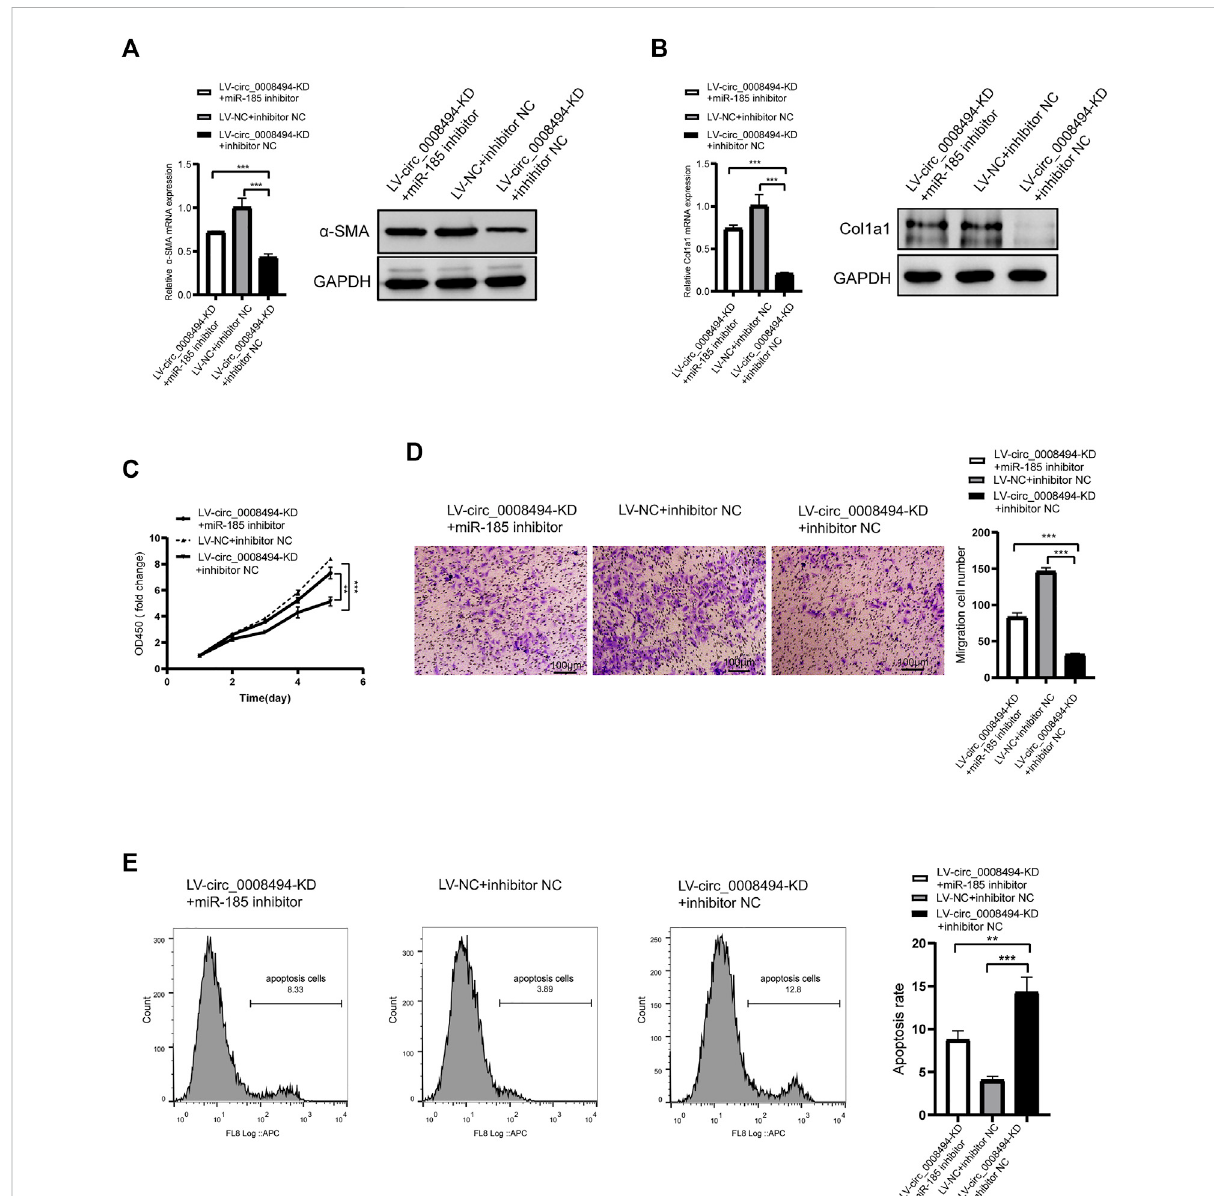
FIGURE 6 Suppressing circ_0008494 inhibits activation, proliferation, migration of HSCs and promotes their apoptosis through miR-185-3p (A and B) miR-185-3p inhibitor was transfected into stable LV-circ_0008494-KD LX-2 cells. miRNA inhibitor NC was transfected into stable circ_0008494- interfering cell line as a control or LX-2 NC cells as a normal control. 48 h after transfection, the mRNA and protein expression levels of a-SMA and Col1a1ineachgroupweredetectedqRT-PCRandwesternblotassays (CandD) Aftertransfectionasabove,proliferationandmigrationofLX-2 cellsineachgroupweredetectedbyCCK8andtranswellassays.InCCK8assay,theODvalueatday1wasnormalizedto1andthedataareexpressed as fold (E) After transfection as above, apoptosis was detected by Annexin V-APC single staining combined with fl ow cytometry was performed in eachgroup.TheRNAlevelswerenormalizedtototalGAPDH.TheproteinlevelswerenormalizedtototalGAPDH.Statisticalanalysis:Student t -tests. ** and *** stand for p < 0.01and p < 0.001, respectively. Experiments were repeated independently three